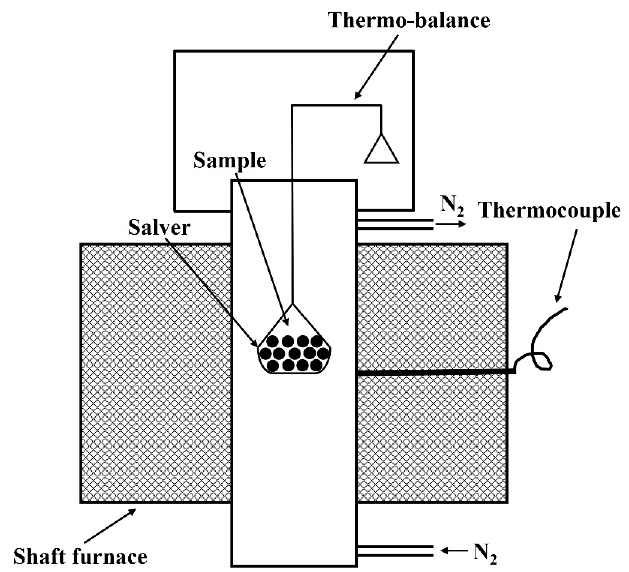
Figure 5. The diagram of the experimental equipment.